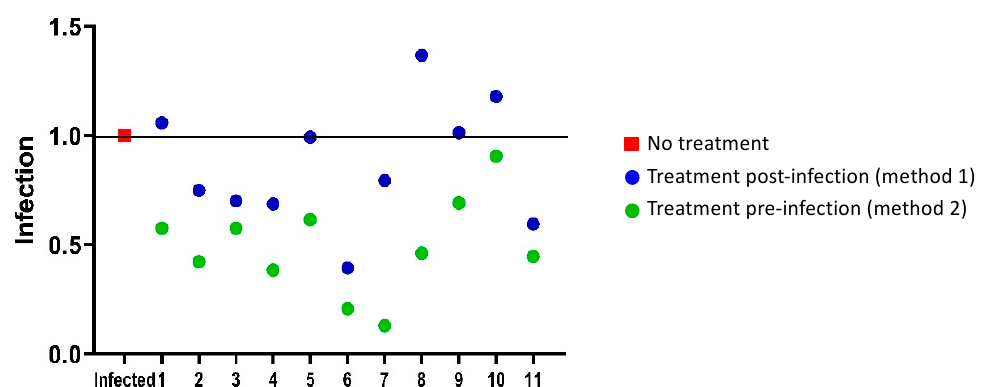
Figure 6. AZT-derivatives exhibit pre-exposure prophylaxis potential . Plotted fold-change in the frequency of HIV-1 infected CD4 + T cells upon treatment with different AZT-derivatives.